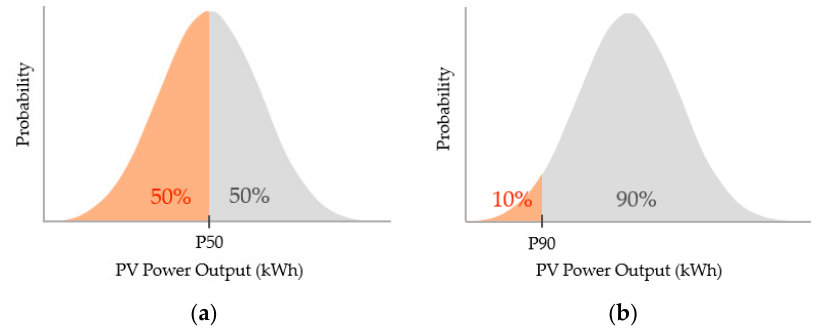
Figure 1. P50 and P90 values represented in a normal distribution: ( a ) P50; ( b ) P90.